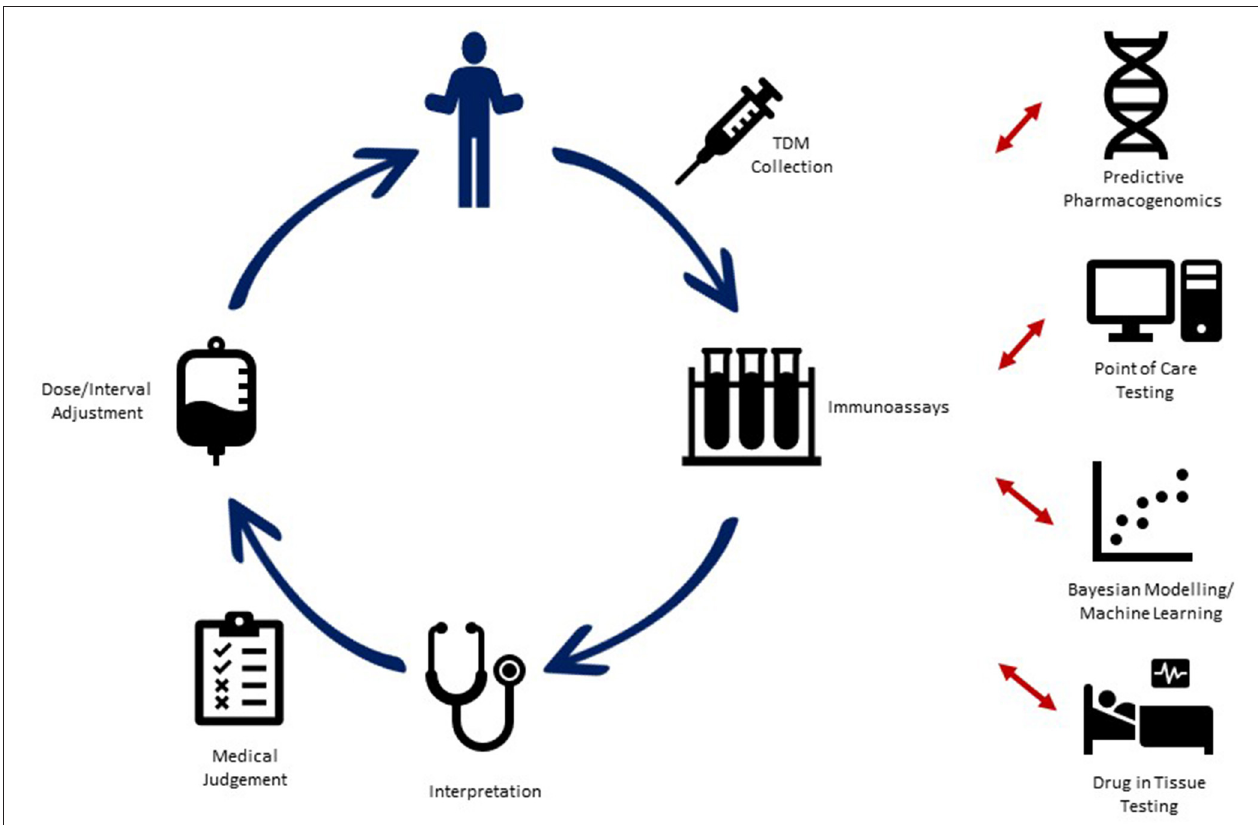
FIGURE 1 | Current utilization of therapeutic drug monitoring (TDM) in pediatric IBD, along with proposed advances for novel TDM strategies into the future.